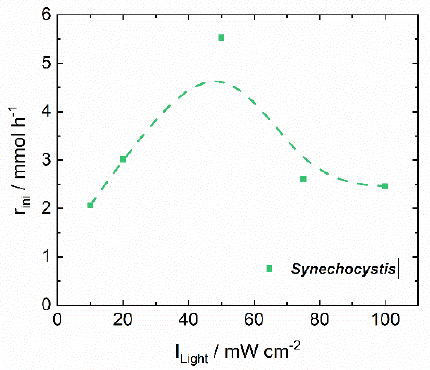
Figure 2. Initial O 2 evolution rate of Synechocystis using simulated sunlight (AM 1.5 G filter) at a cell concentration of 0.163 g dm −3 (OD 750 = 1).